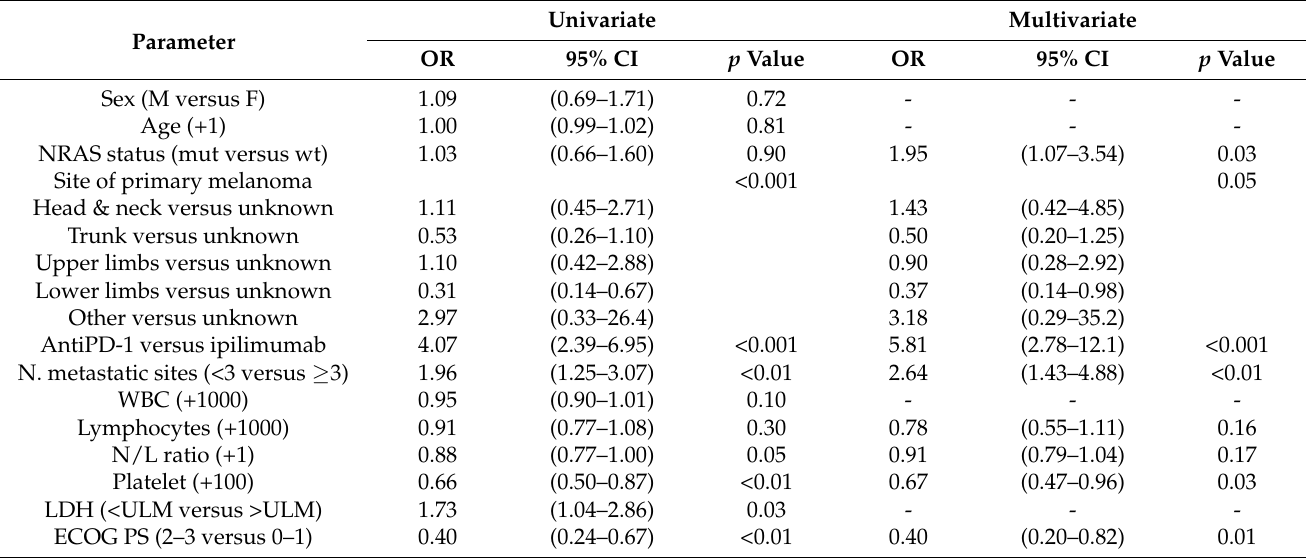
Table 6. Univariate and multivariate analysis of disease control rate including complete response, partial response and stable disease lasting more than 6